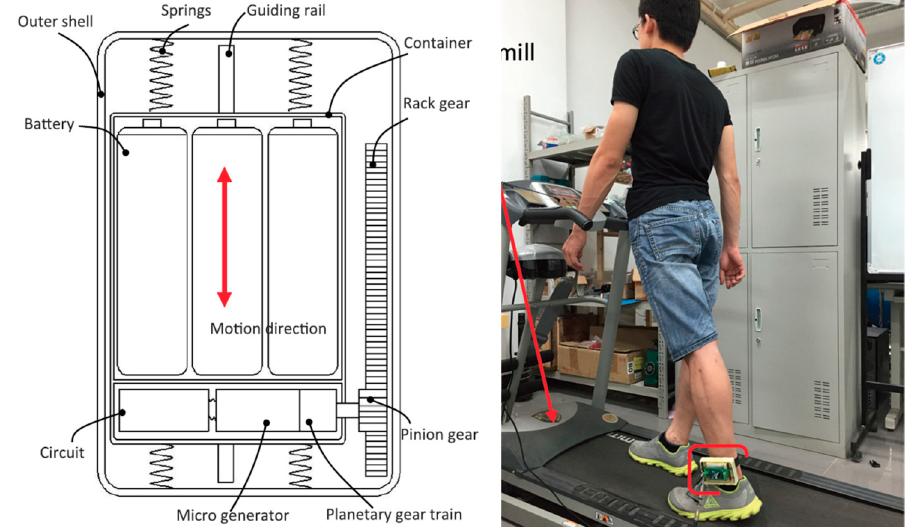
Figure 6. Foot-strike wearable energy harvester using inertial motion [45]: Schematic of the energy harvester ( left ) and energy harvester mounted on the ankle ( right ). Reproduced under a Creative Commons Attribution CC-BY 3.0 license.